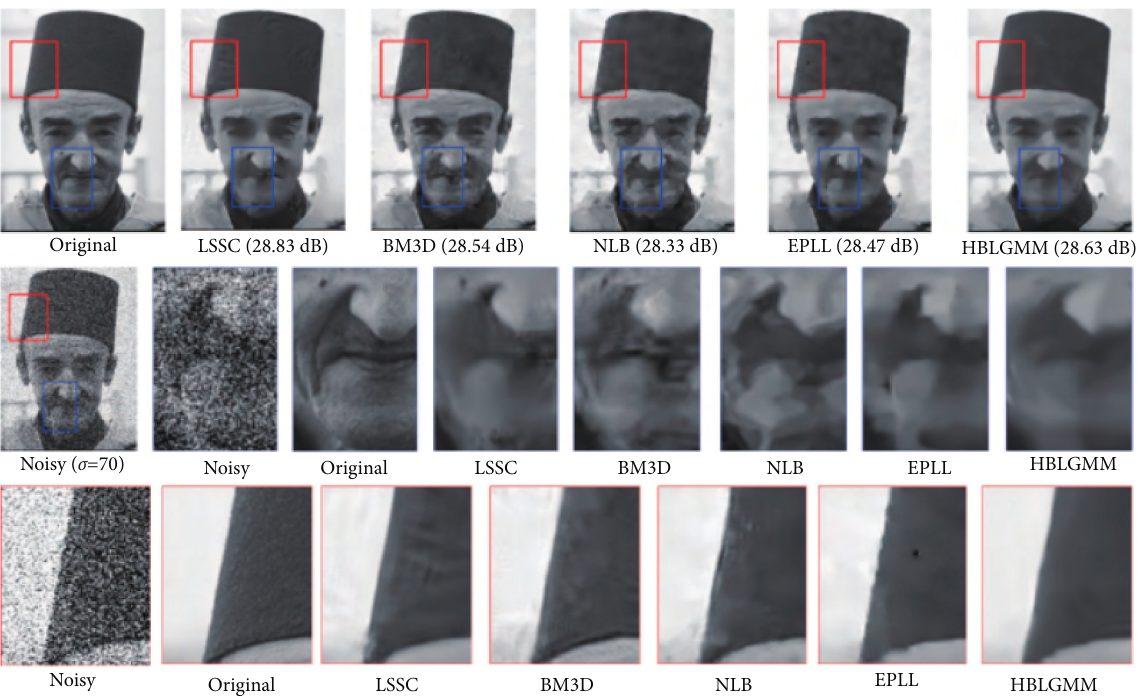
Figure 7: Comparison of the visual quality of